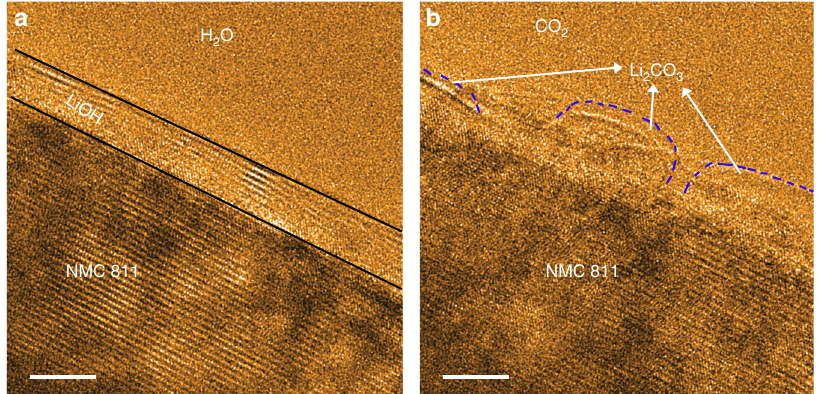
Fig. 4 Passivation layers evolution with the presence of CO 2 . a The surface of NMC811 after exposed to water vapor (PH 2 O = 5 × 10 − 2 Torr) for 30 mins, indicating a uniform passivation layer of LiOH. The black lines outline the boundary of LiOH. b The surface morphology of NMC811 after the water vapor exposure and followed by exposure to CO 2 for 10 mins (PCO 2 = 5 × 10 − 2 Torr), leading to the formation of Li 2 CO 3 . The blue dashed lines outline the boundary of each Li 2 CO 3 island. Scale bar, 5 nm a , b